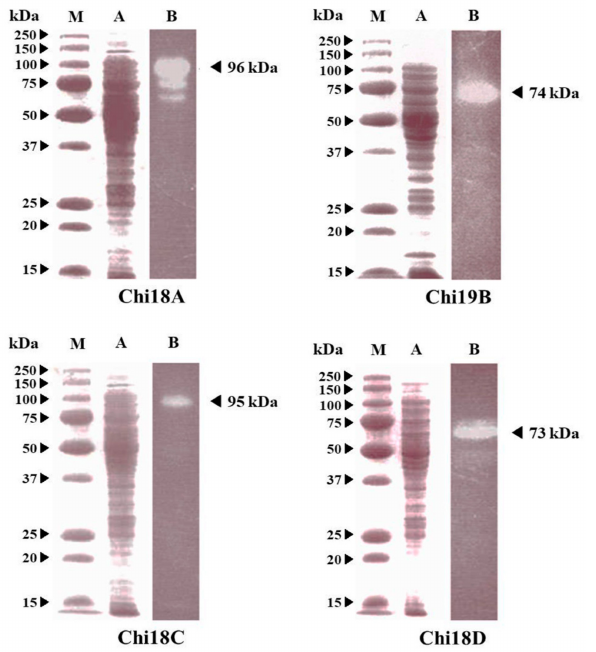
Figure 16. Molecular masses of the chitinases produced by Chi18A, Chi19B, Chi18C, and Chi18D- containing clones. Lanes M, molecular weight standards; A, stained with Coomassie blue after SDS-PAGE; Lanes B, activity stained with MUCh 2 .